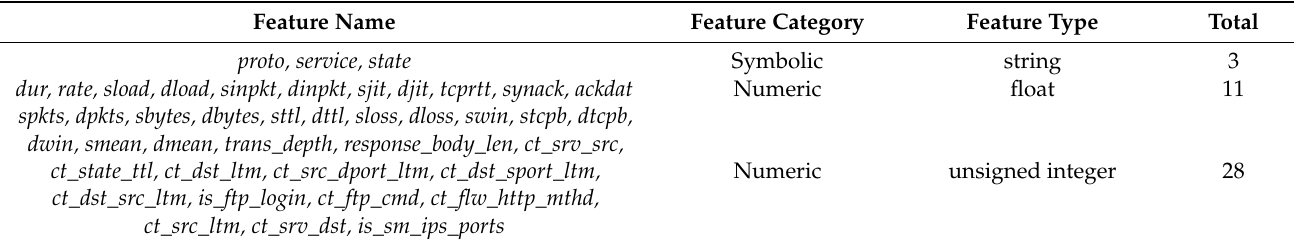
Table 2. Features, categories, and types in the UNSW-NB15